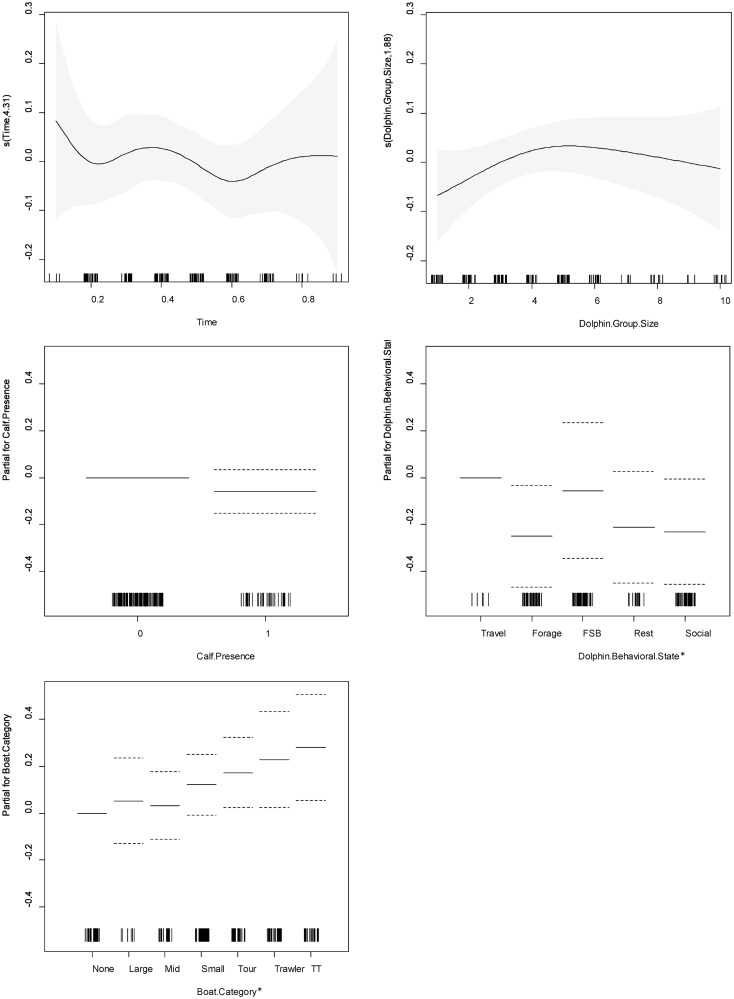
Charts for the partial contribution of individual explanatory variables in the fitted GAM for swimming speed.Includes A) time of day, B) dolphin group size, C) calf presence, D) dolphin behavioral state, and E) vessel category. The rugplot along the x-axis indicates the number of observations for each factor. The gray shading for smooth terms, and the dotted lines for linear terms, indicate the 95% confidence intervals. On the y-axis, values >0 indicate a positive correlation with swimming speed, values <0 indicate a negative correlation, and a value of 0 indicates no effect. An asterisk (*) indicates a variable with a statistically significant effect at alpha level 0.05.